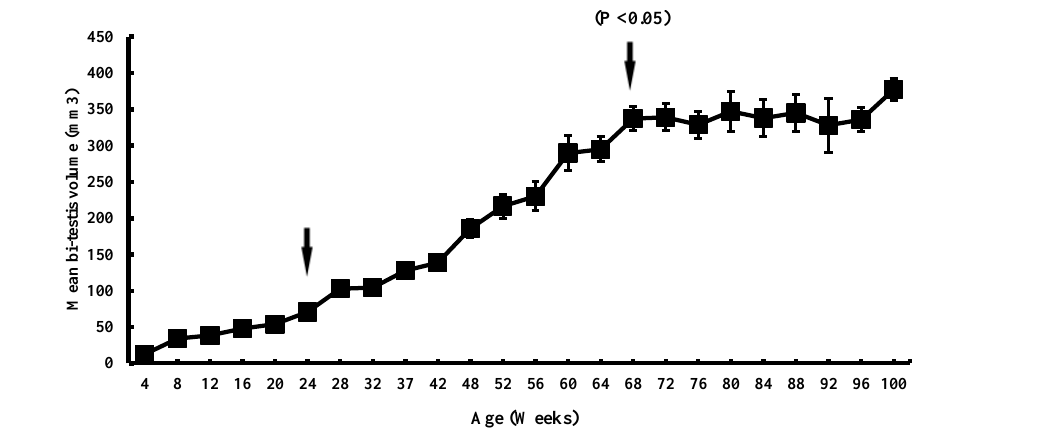
Figure 2. Mean bi-testis volume in the common marmoset from birth until 100 weeks of age ( n = 48). A rapid and statistically significant ( P < 0 . 05) increase in the testis volume was observed from the 24th week onwards until the 68th week of age (arrow). This rapid increase in the testis volume was absent from the 68th week